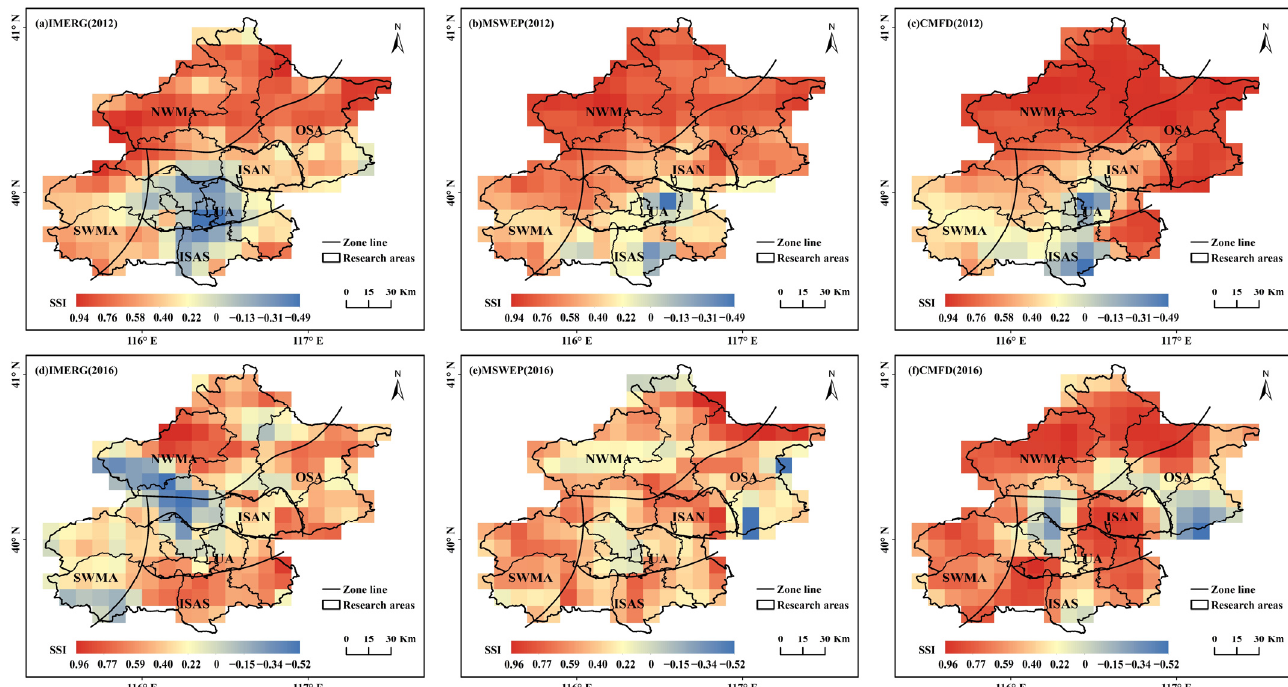
Figure 10. Structural Similarity Index (SSI) of the extreme rainstorms that occurred in Beijing on 21 July 2012 and 20 July 2016: ( a ) IMERG (2012), ( b ) MSWEP (2012), ( c ) CMFD (2012), ( d ) IMERG (2016), ( e ) MSWEP (2016), and ( f ) CMFD (2016).